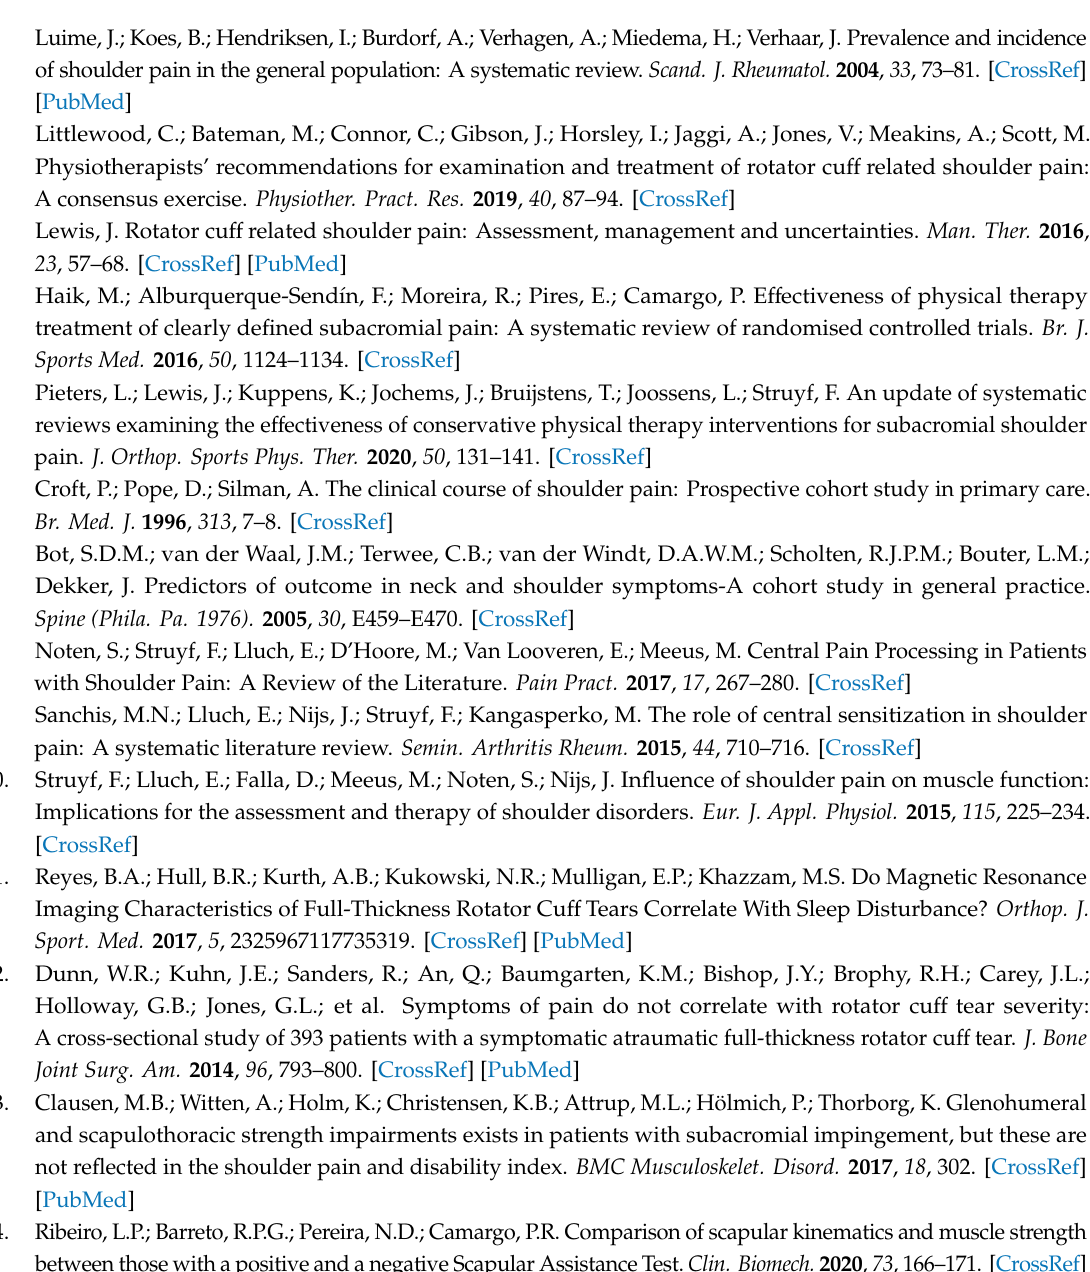
Table S1: Overview of the di ff erent methods used with their specific